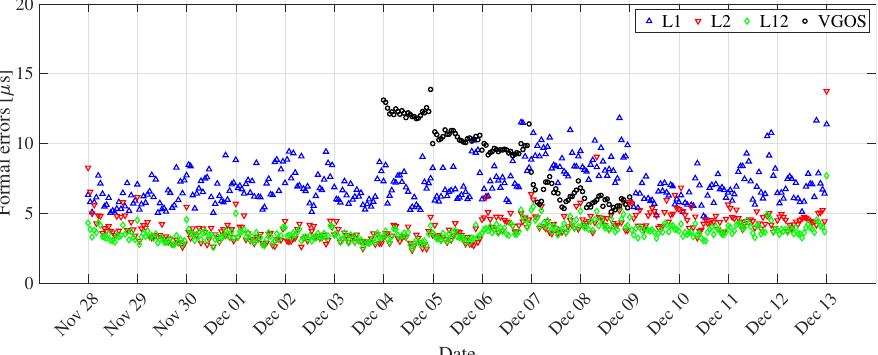
Figure 7. dUT1 formal errors derived from L1, L2, and L12 networks, and VGOS networks for hourly resolution (using global solutions).